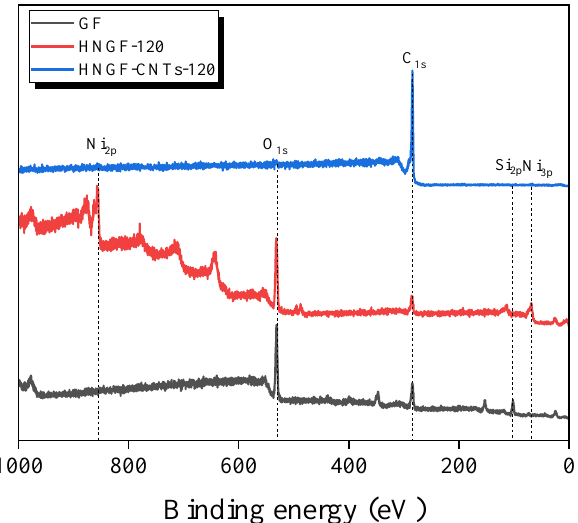
Figure 6. Survey-scan X-ray photoelectron spectra of the glass fibers modified by different treatments.